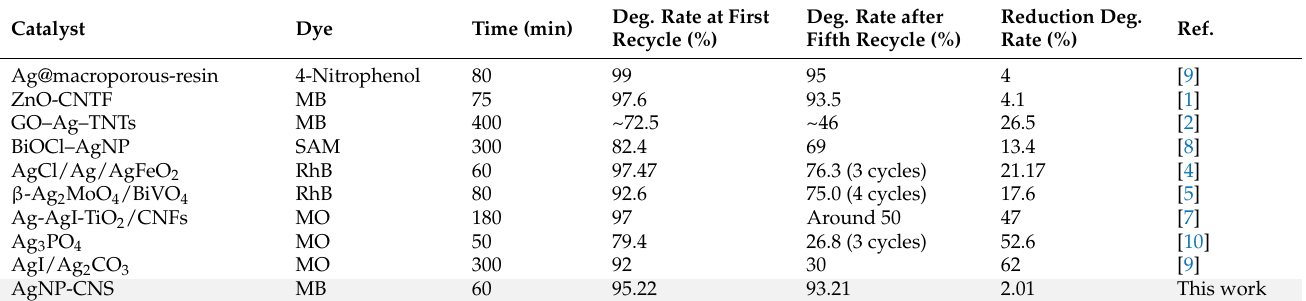
Table 3. Photocatalytic recycle stability of the AgNP–CNS photocatalyst and other photocatalysts reported in the